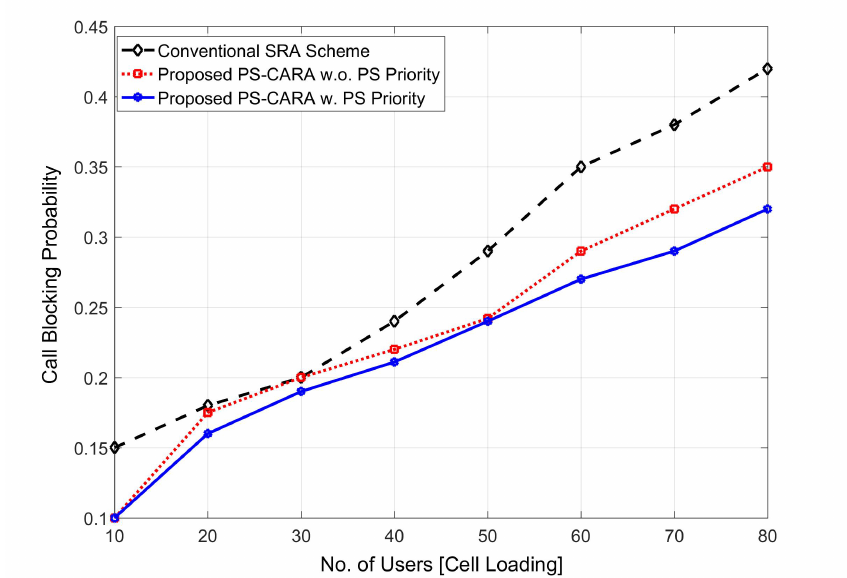
Figure 9. Call blocking probability of the proposed PS-CARA